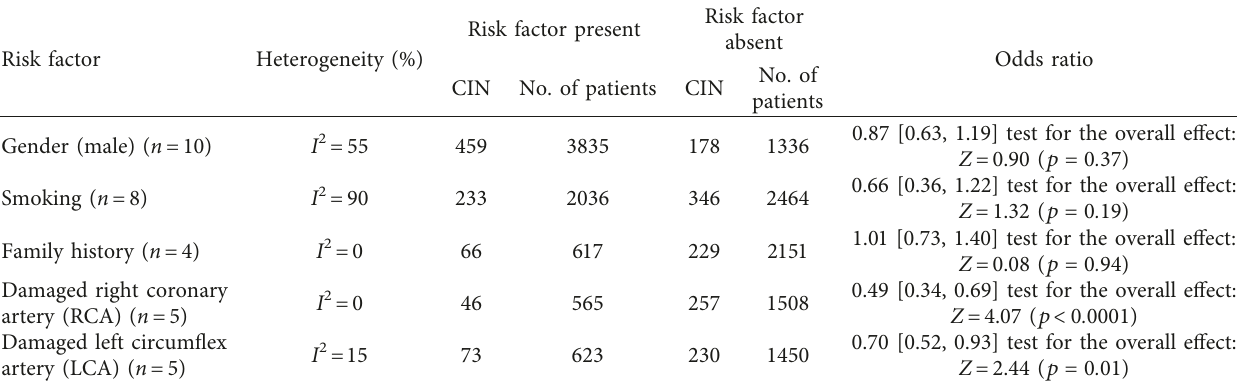
Figure 2: (a)–(i) The positive associations between some risk factors and CIN. HTN, hypertension; DM, diabetes mellitus; PMI, prior myocardial infarction; LAD, left anterior descending; LVEF, left ventricular ejection fraction (%). Crit 1: CIN defined as increase in serum creatinine ≥ 25%. Crit 2: CIN defined as increase in serum creatinine ≥ 0.5mg/dL. Crit 3: CIN defined as increase in serum creatinine of ≥ 25% or ≥ 0.5mg/dL. Crit 4: CIN defined as an increase in serum creatinine > 25% or a decrease in the estimated glomerular filtration rate (eGFR) < 25%. Crit 5: CIN defined as a rise in serum creatinine > 26.5 μ mol/L or > Table 2: Related data on other risk factors.